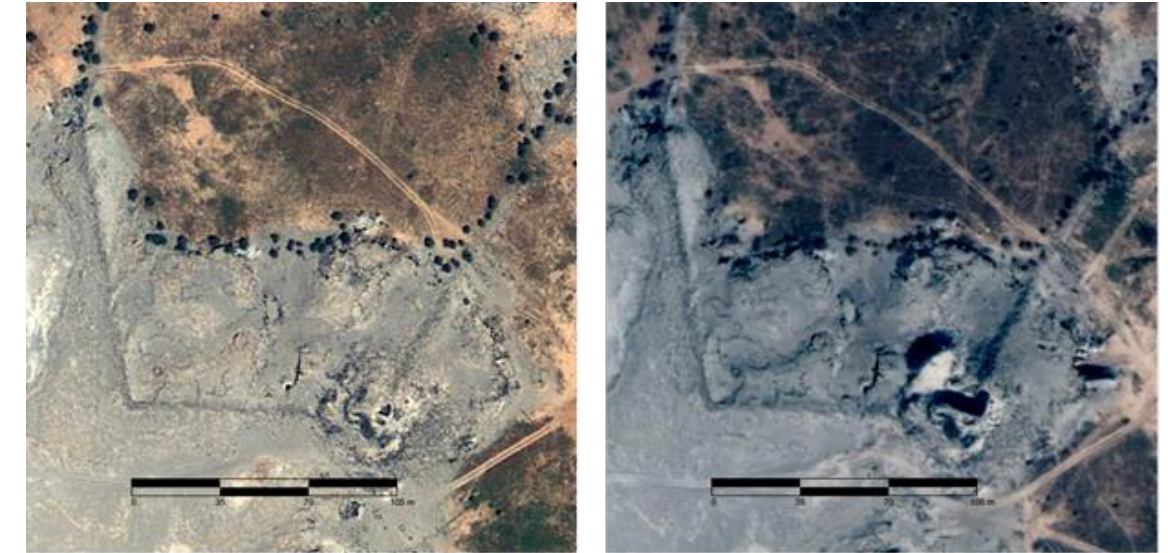
Figure 14: Comparison of satellite images of a possible bathhouse or church ruin between 2010 (L) and 2016 (R). The rearranged debris mound is clearly visible. View from